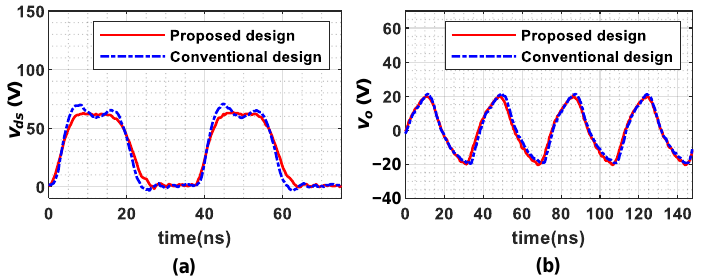
Figure 15. Voltage waveforms of the class Ф 2 inverter at V in = 30 V, R L = 16 Ω . ( a ) Switching node voltage; ( b ) output voltage.